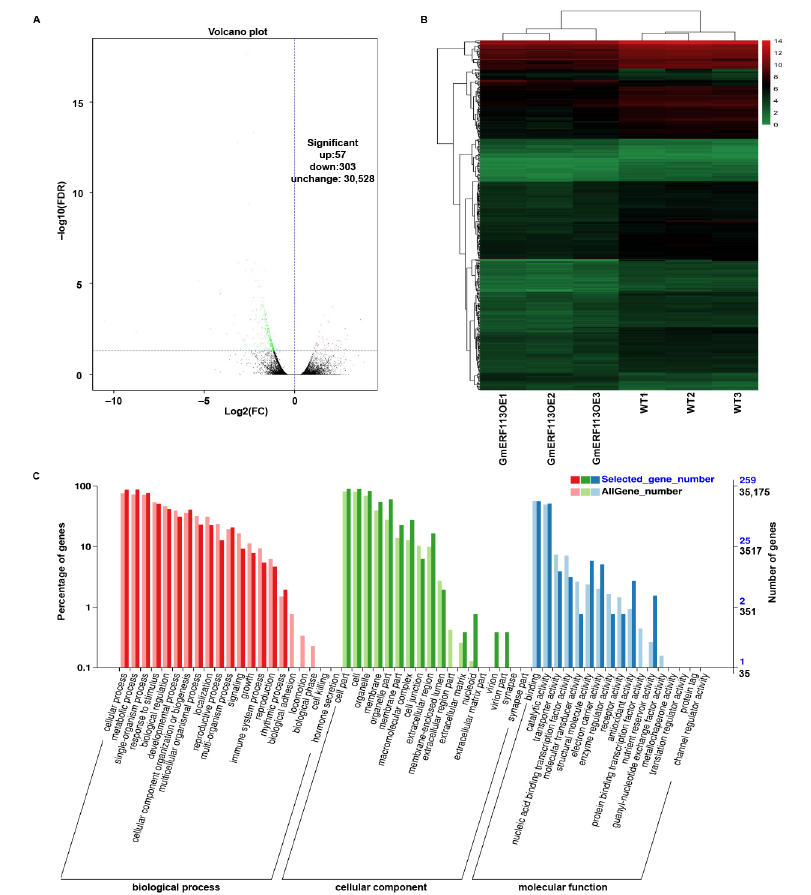
Figure 7. Transcriptomic analysis of gene expression profiles in response to GmERF113 overexpression. ( A ) Volcano plots of significantly differentially expressed genes in GmERF113-OE vs. wild-type soybean plants after the RNA-seq analysis. ( B ) Heat map of significantly differentially expressed genes between the WT and GmERF113-OE transgenic soybean plants, as determined using an RNA- seq analysis. Using a false discovery rate < 0.05 and a fold change ≥ 1 as the screening criteria, a total of 360 differentially expressed genes (DEGs) were identified. The scale bar indicates the fold changes (log 2 values). ( C ) Gene Ontology functional classification of the differentially expressed genes. The differentially expressed genes were placed into the three main GO categories: biological process, cellular component, and molecular